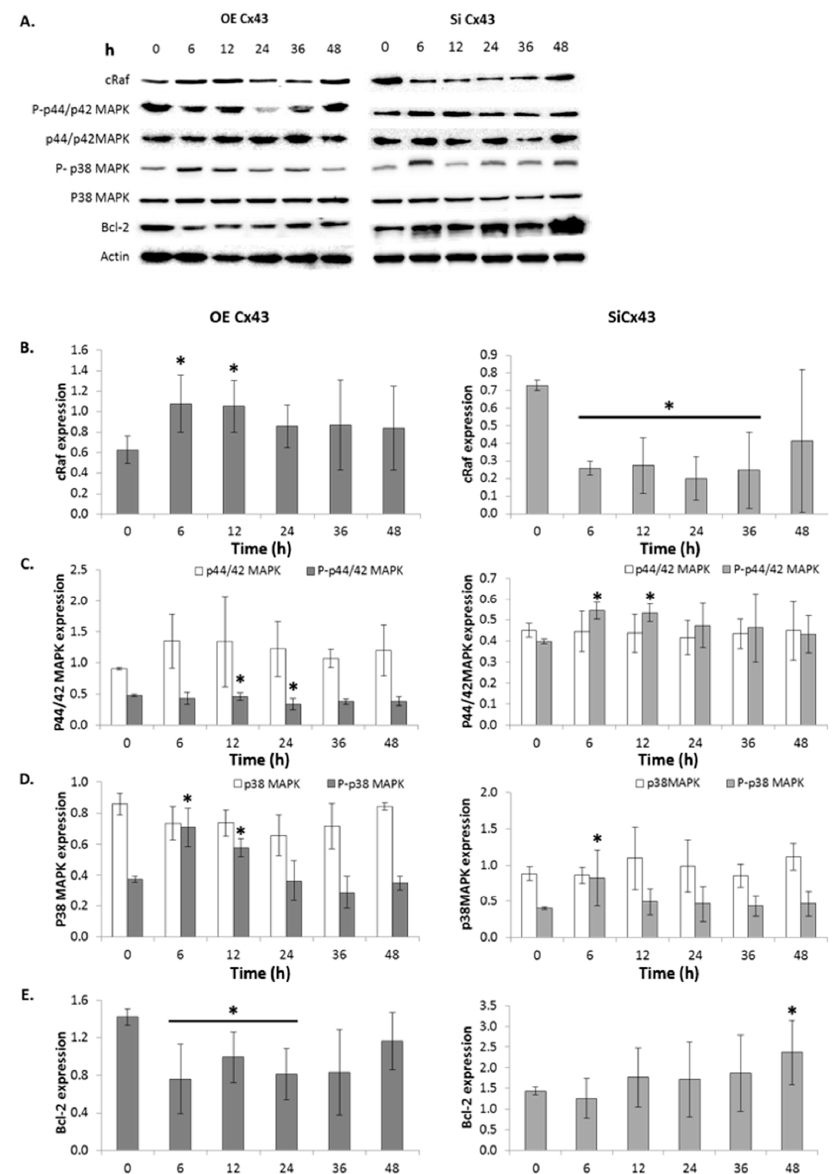
Figure 7. Altering connexin 43 affects expression of signaling molecules involved in cellular survival. ( A ) Raw and ( B – E ) graphical representation of western blot analysis of cRaf, phosphorylated (P) and unphosphorylated MAPK (p44/42 and p38), and Bcl-2 expression levels relative to loading control in FMC2u cells transfected with either cDNA of Cx43 to induce overexpression ( Left ) or siRNA to silence Cx43 ( right ). Actin used as a loading control. n = 3. * p -value < 0.05 compared to respective transfection control.